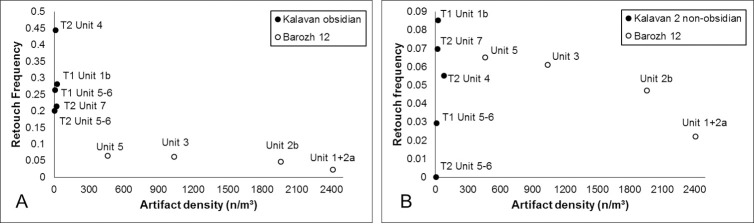
Binary plots of artifact density and retouch frequency for sedimentary units at Barozh 12 (open circles) and Kalavan 2 (filled circles), with obsidian artifacts (A) and non-obsidian artifacts at Kalavan 2 (B). Data exclude artifacts < 2 cm in maximal dimensions to avoid differences among sedimentary units in assemblage preservation and winnowing of small artifacts due to post-depositional processes.